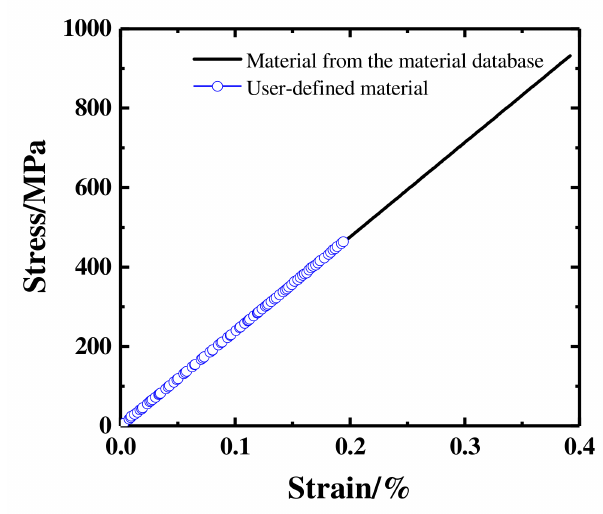
Figure 13. Comparison of stress-strain